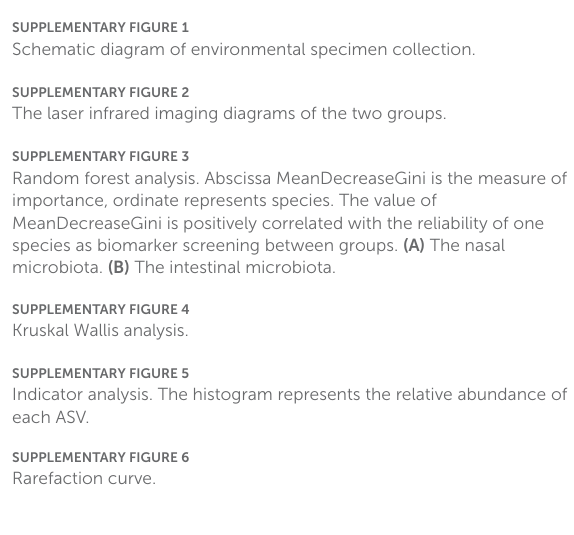
SUPPLEMENTARYFIGURE2 The laser infrared imaging diagrams of the two groups.